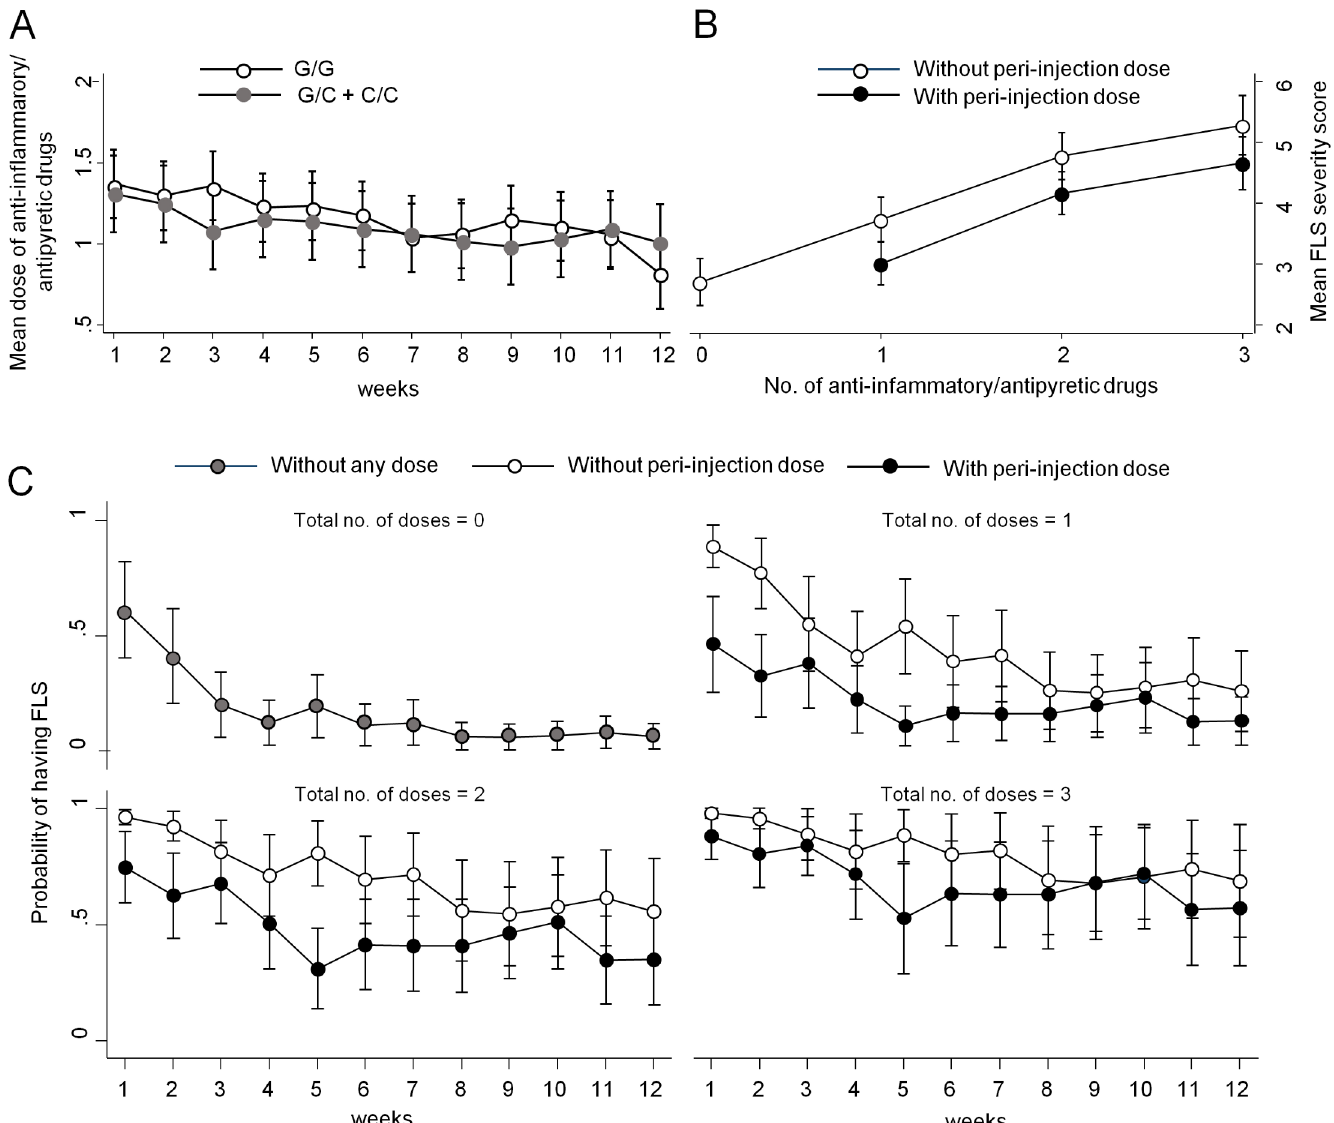
Fig 3. Consumption of anti-inflammatory/antipyretic drugs and its effects on FLS. (A) Comparison of mean number (no.) of anti-inflammatory/ antipyretic drugs taken during the follow-up by patients bearing at least one C allele at position -174 of IL-6 gene vs. those bearing two G alleles at the same position. (B) Comparison of mean FLS severity score in patients taking the first dose of anti-inflammatory/antipyretic drugs in the peri-injection period vs. those that assumed the first dose hours later. (C) Effect of the peri-injection dose of antipyretic/anti-inflammatory drug on the probability of developing FLS in patients taking different total doses of antipyretic/anti-inflammatory